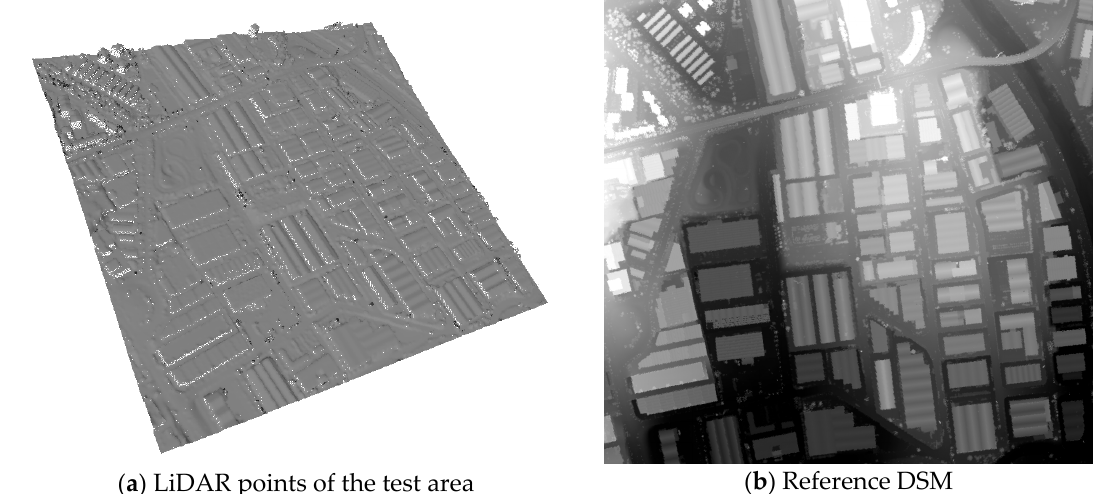
Figure 14. Reference data. LiDAR—light detection and ranging.